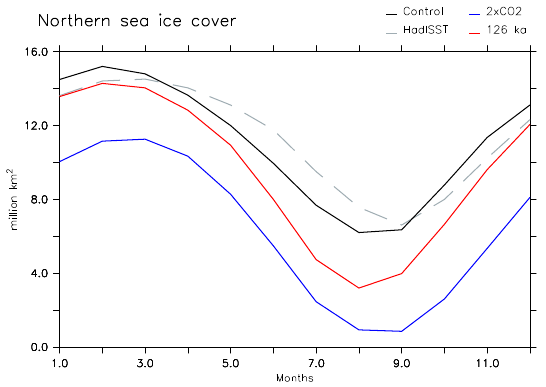
Fig. 4. Monthly seasonal cycle of Northern Hemisphere sea ice extent for present day (black), 126ka (red) and 2 × CO 2 (blue) sim- ulated by IPSL-CM4. Present day (1900–2010) climatological data (Rayner et al., 2003) are also displayed (dashed